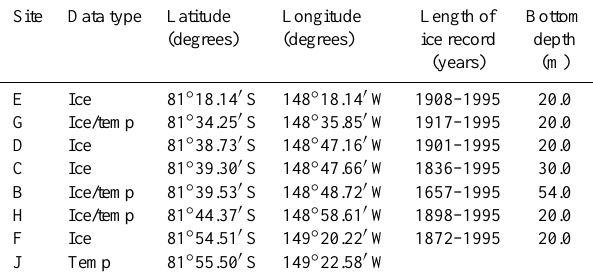
Table 1. The Siple Dome shallow ice core sites (B–H) and borehole temperature measurement sites (G, B, H, J) used in this